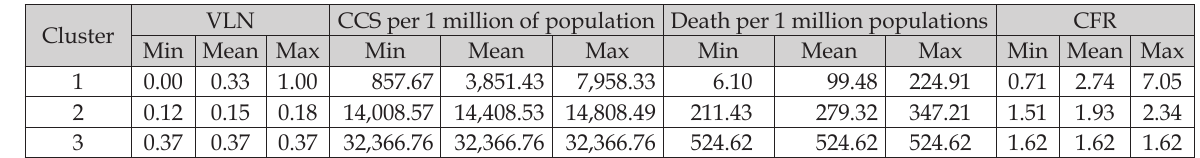
Table 4. Descriptive statistics for each cluster.